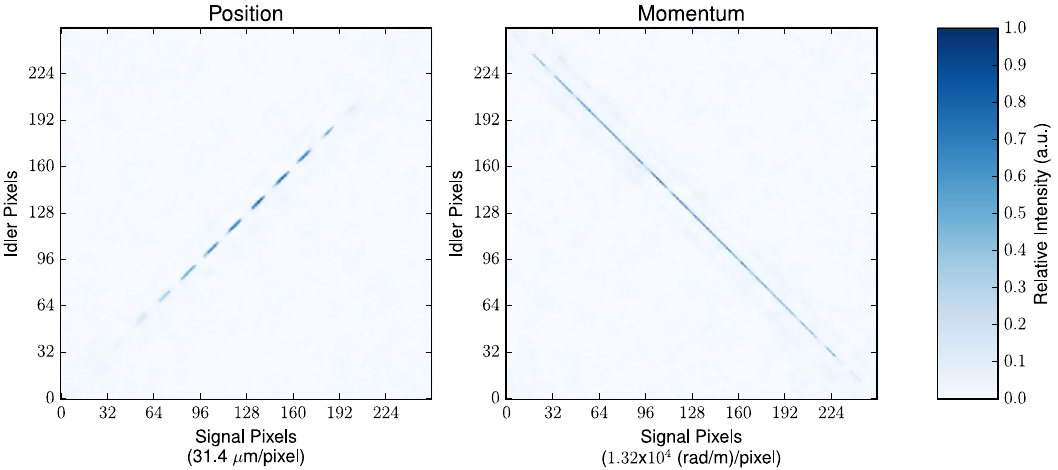
FIG. 3. Representative recovered joint-distributions in position and in momentum for a 16 × 16 pixel ( N ¼ 256 × 256 ) discretization. Only M ¼ 4439 measurements were needed, about 0 . 07 N . Gaps along the position diagonal occur because of reshaping to one dimension — these regions were outside the marginal width. Position and momentum units refer to the transverse plane at the nonlinear crystal ( z ¼ 0